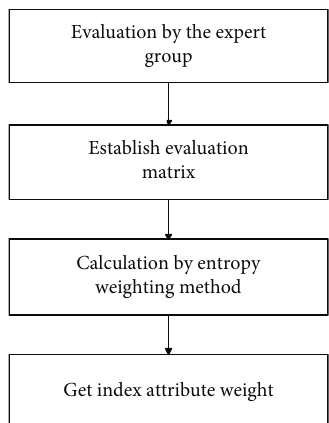
Figure 4: Flow chart of determining attribute weight by entropy weight